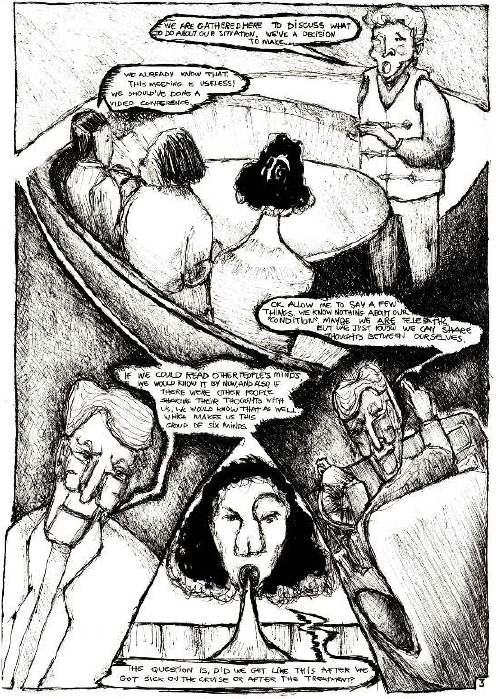
Figure 4: Plate 3, Diamond Princess II